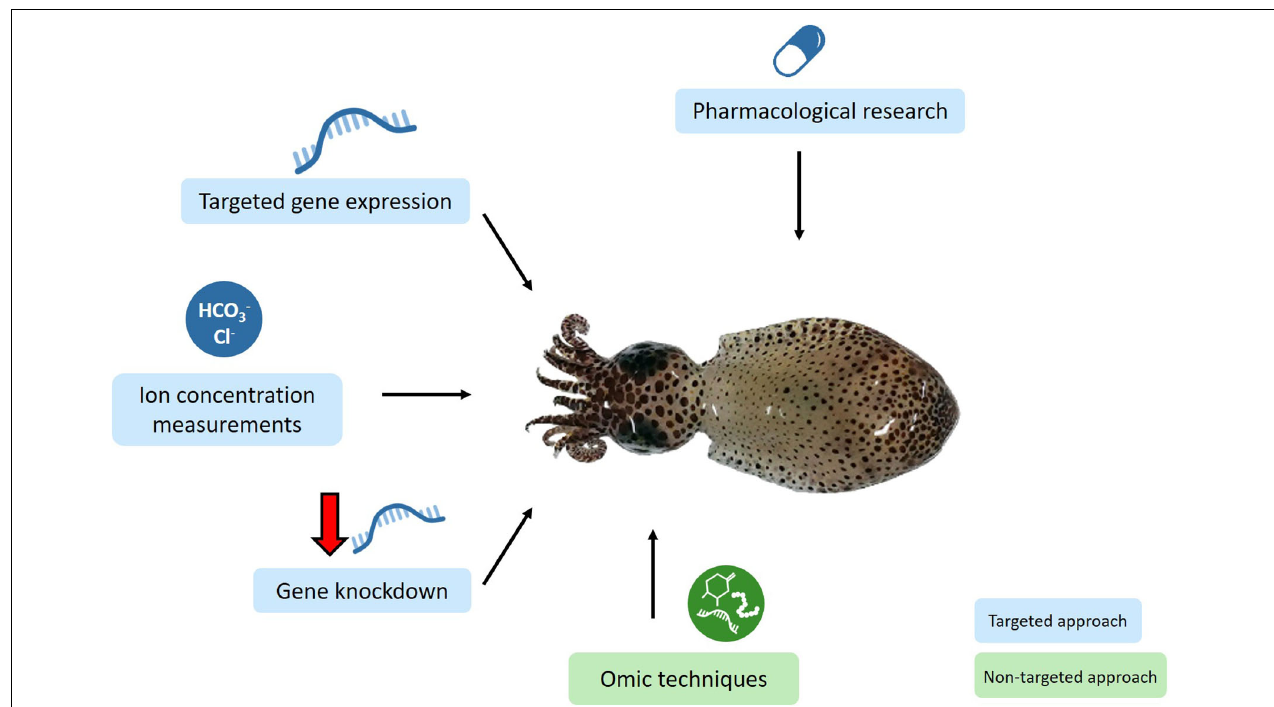
FIGURE 3 | Conceptual diagram illustrating the techniques that will be useful for future research to assess the neurobiological mechanisms underlying behavioral change at elevated CO 2 in marine invertebrates. Targeted approaches will test specific hypotheses and include pharmacological research administering drugs that target a specific receptor, measuring the expression of specific genes, measuring the concentration of HCO 3 − and Cl − ions in the relevant intra- and extra-cellular fluids, and knocking down the expression of specific genes. Omic techniques such as transcriptomics, proteomics and epigenomics will provide a non-targeted approach which does not require a priori hypotheses and will likely lead to the development of new hypotheses. Squid image taken by the author,